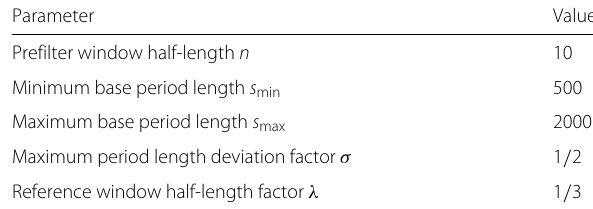
Table 2 Parameters for period detector on ECG database Parameter Value Prefilter window half-length